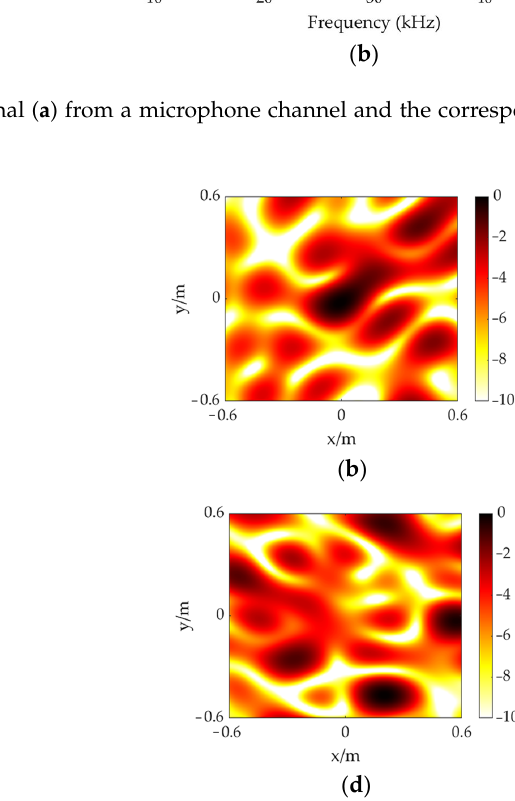
Figure 10. Time domain signal ( a ) from a microphone channel and the corresponding frequency domain information ( b ).